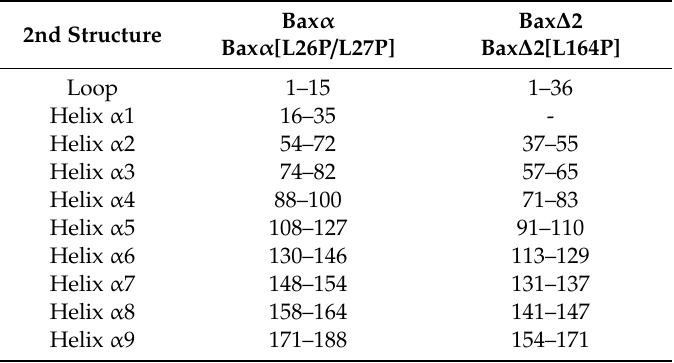
Table 1. Amino acid indexes corresponding to helix